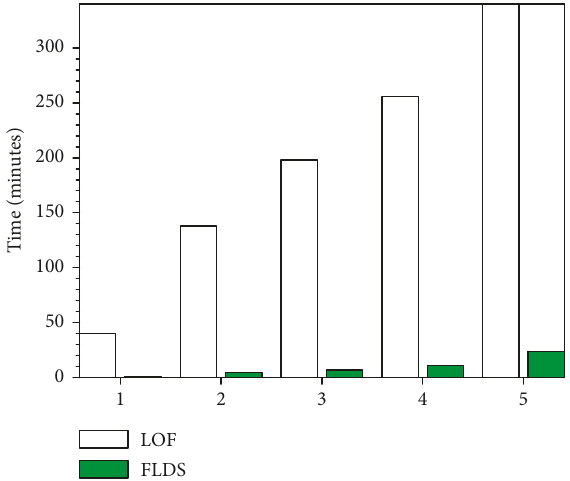
Figure 8: Running time comparison between FLDS and LOF for five AWID data